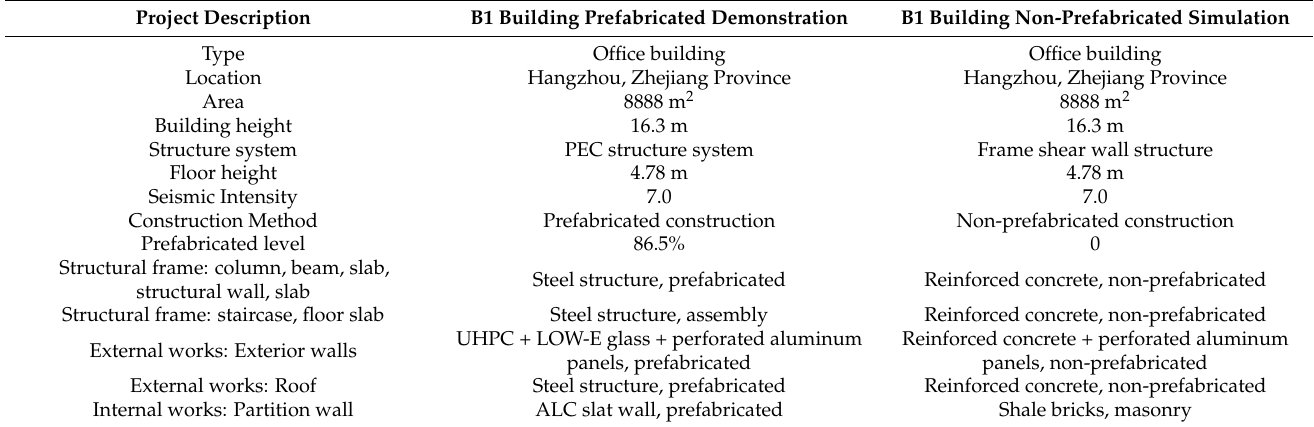
Table 1. Comparison of carbon emissions between prefabricated empirical and non-prefabricated